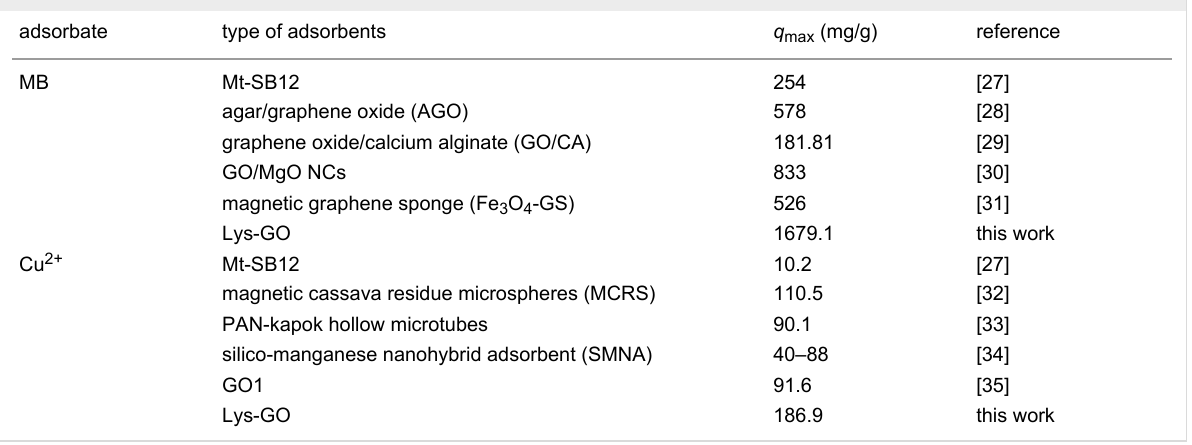
Table 3: Comparison of MB and Cu 2+ adsorption capacities on various materials.